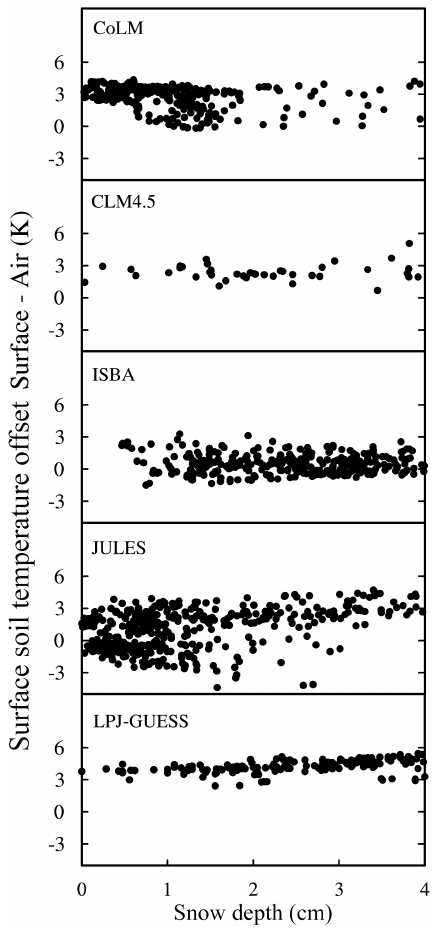
Figure 10. Mean surface temperature offset (difference in mean winter temperatures between surface soil and air, averaged over 1980–2000) as a function of snow depth for grid points where aver- age snow depth <